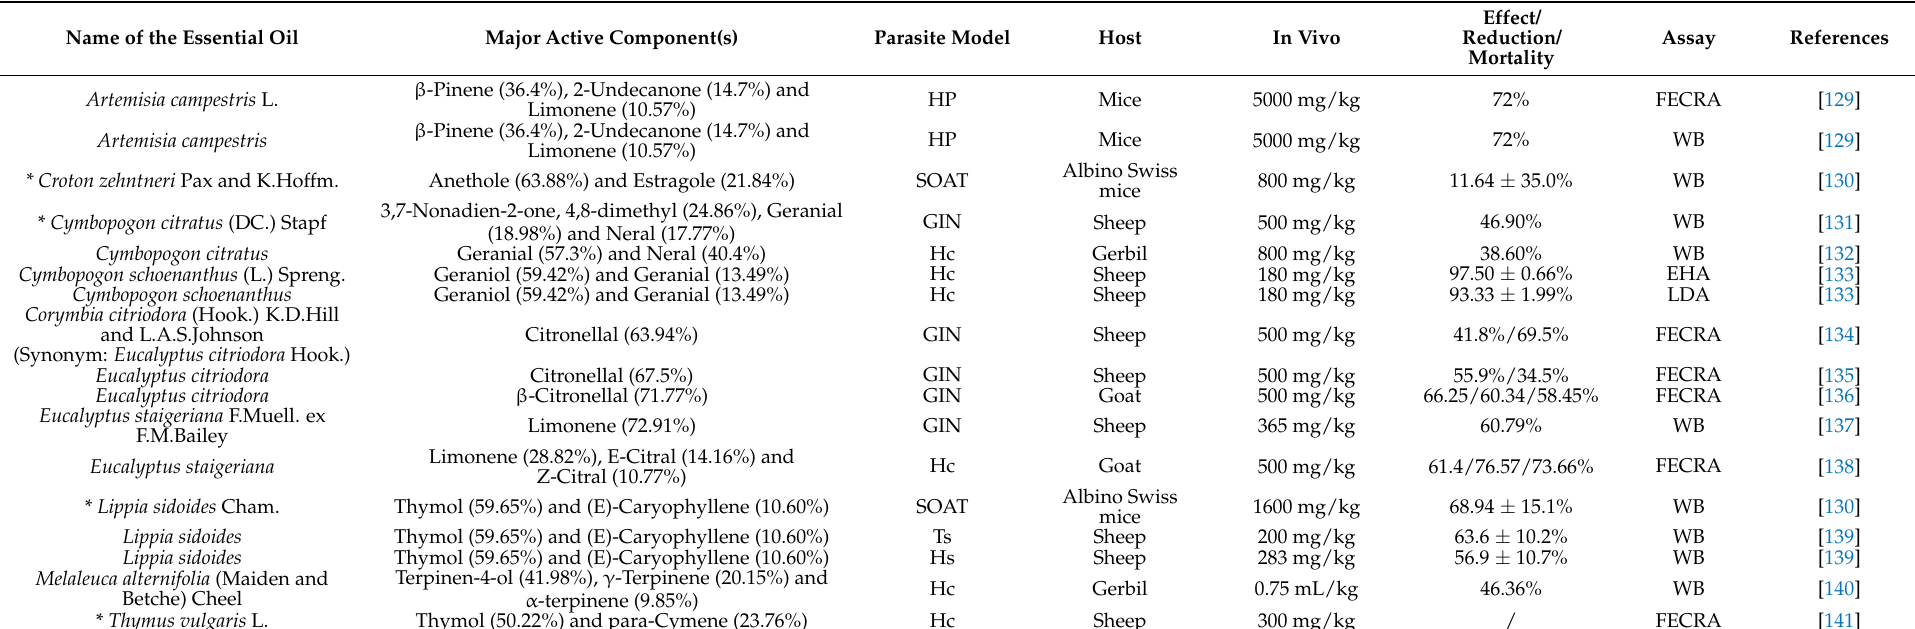
Table 1. List of selected essential oils and their major constituents with in vivo models (for an expanded list, see Supplementary